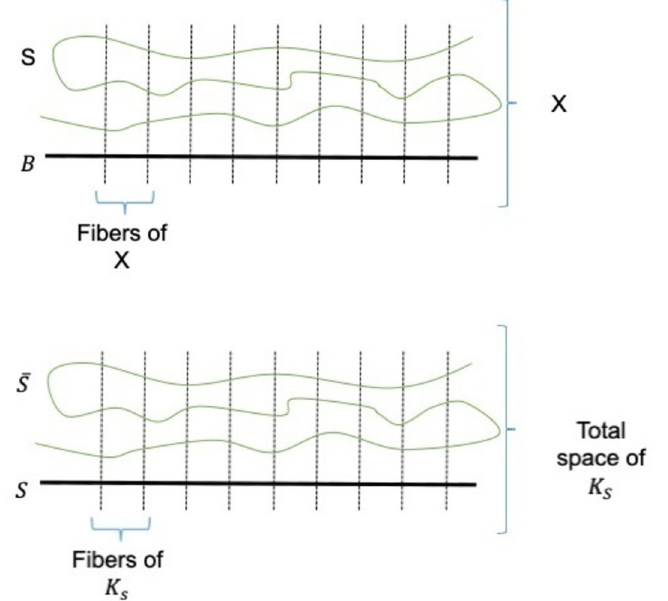
Figure 1 . Top: spectral cover embedded in elliptically fibered Calabi-Yau (compact). Down: spectral cover embedded in the total space of canonical bundle (non-compact). The neighborhood of the zero section in X is mapped to the total space of the canonical bundle [77]. Table 2 . SO(10) models possible Yukawa couplings. The middle column corresponds to the zero modes that can have non-zero Yukawa couplings. Note that for the last case there are three different